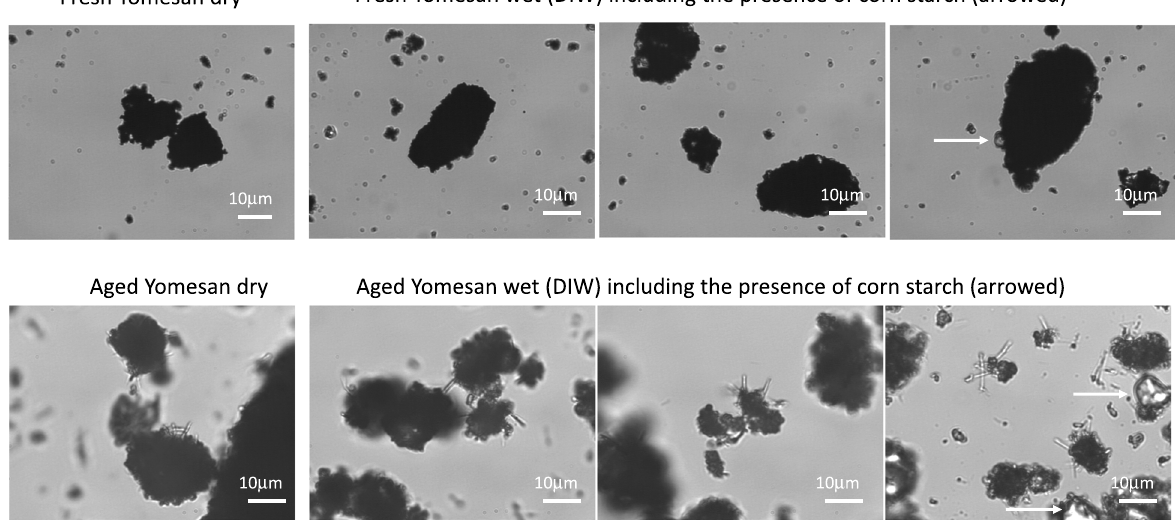
Fig. 12 Optical microscope images of Yomesan powder: (top) a sample of featureless particulate aggregates of the fresh powder, and (bottom) crushed Yomesan aged several weeks at room temperature in a closed but frequently opened vial. Initial images (left) show dry material and (right) three images of the Yomesan powders suspended in deionized water. Needle-shaped crystals are evident on the aged particulate aggregates. Corn starch particles are indicated by arrows in the far-right image.